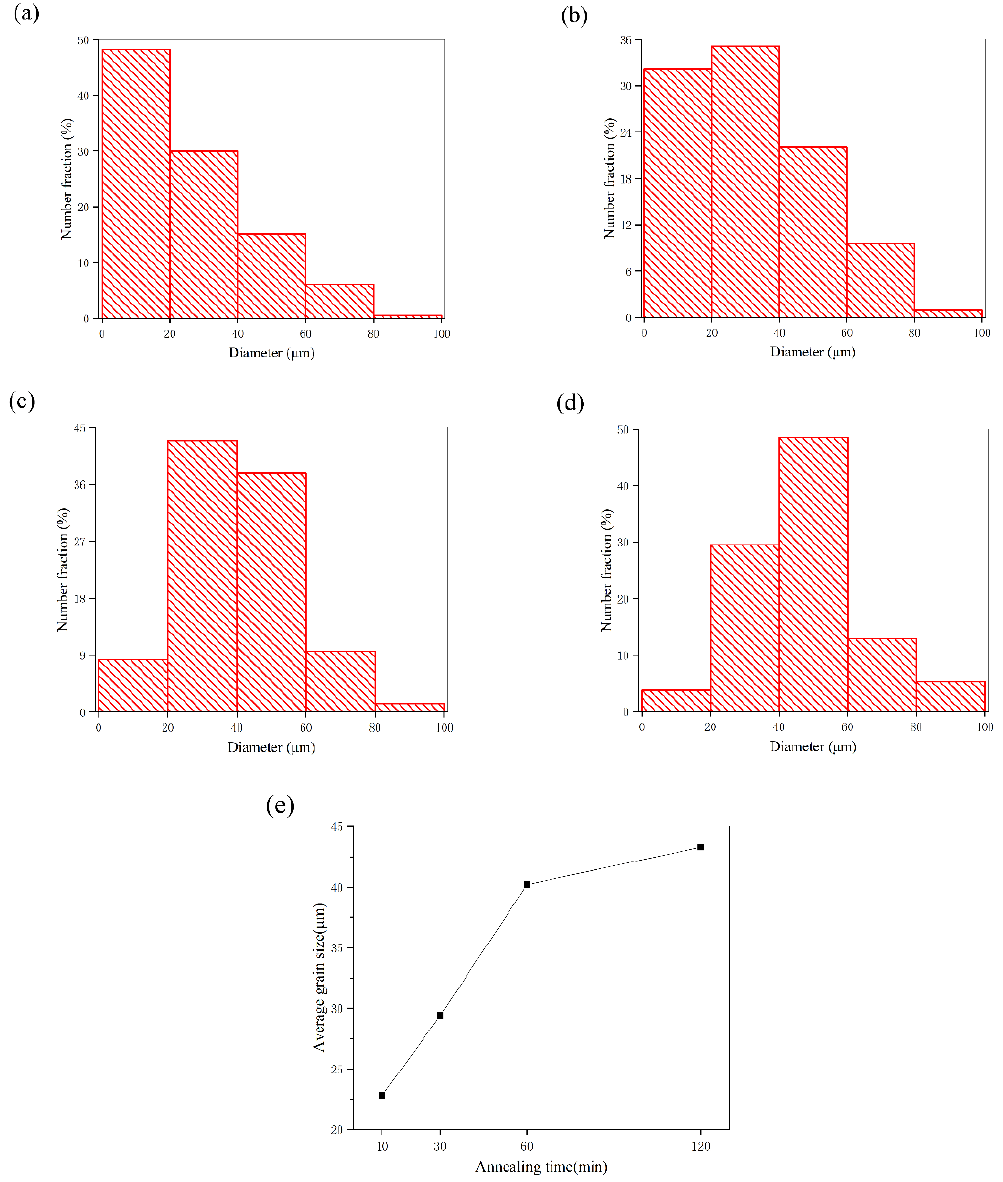
Figure 6. Grain size distribution maps Ni-36.6W-15Co after annealing for ( a ) 10 min, ( b ) 30 min, ( c ) 60 min, ( d ) 120 min at 1150 ° C and ( e ) line chart of average grain size.